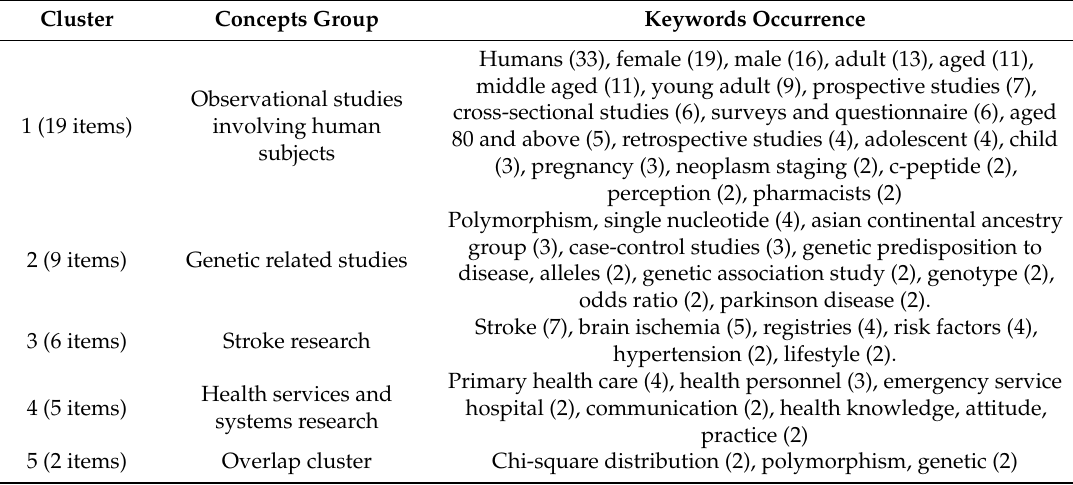
Table 3. Frequent Keywords and Cluster Conceptualizations.